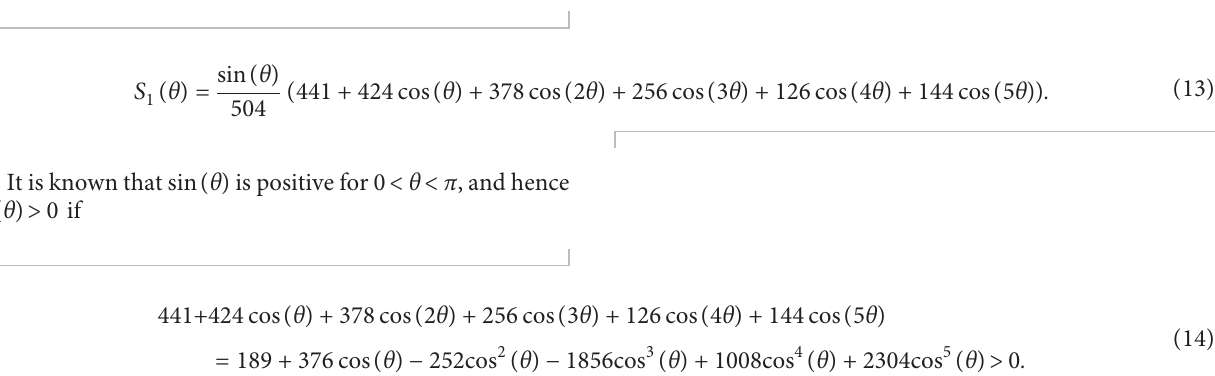
Figure 4: Image of D under the mapping h